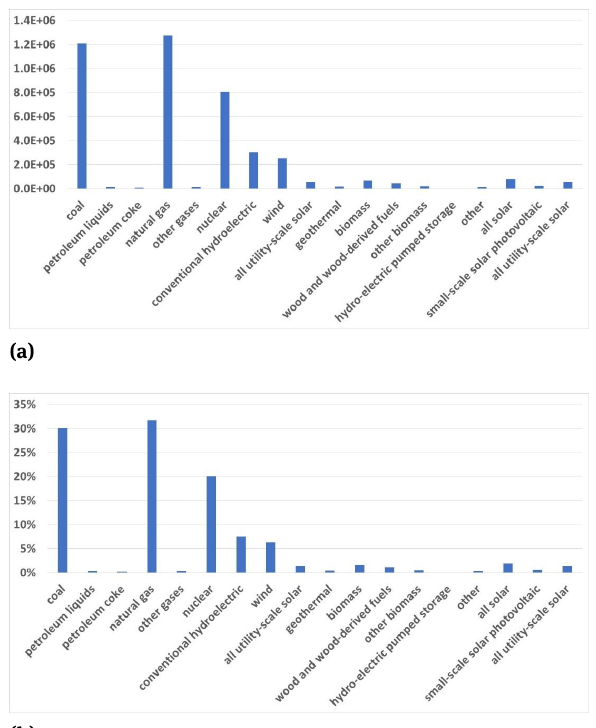
Figure 1: Electricity generation in the U.S. by source, 2017 data from [2]; a) generation in GWh; b) generation in the percentage of the